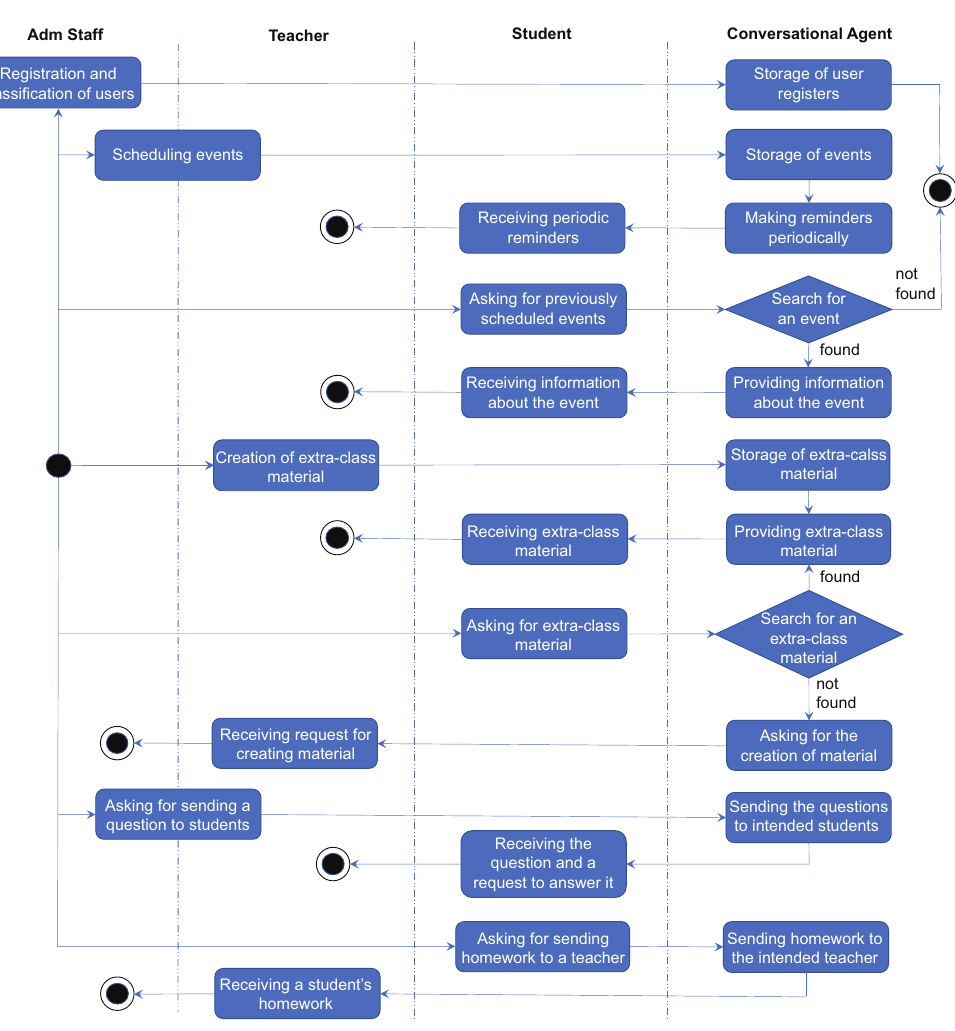
Figure 4. Some activities performed by user roles with the help of the conversational